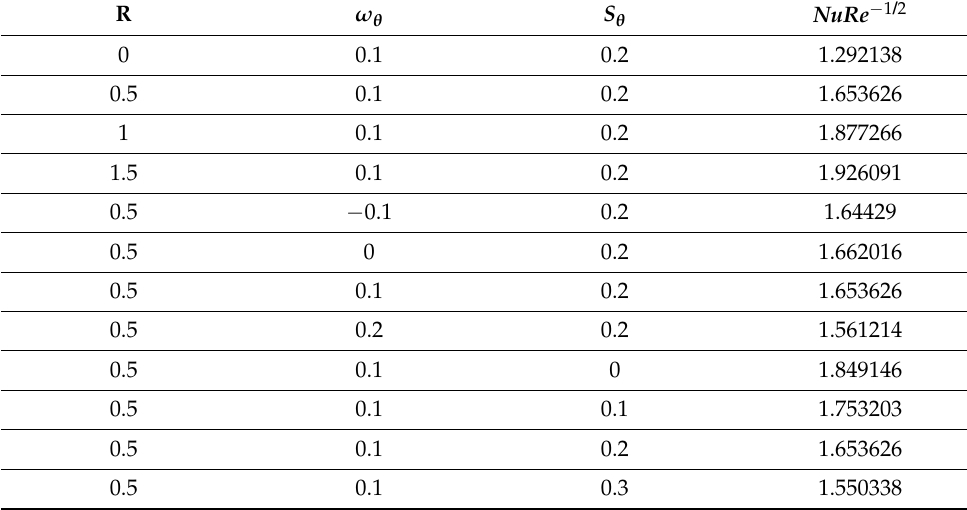
Table 3. Numerical study of NuRe − 1/2 for various parameters R, ω θ , and S θ .